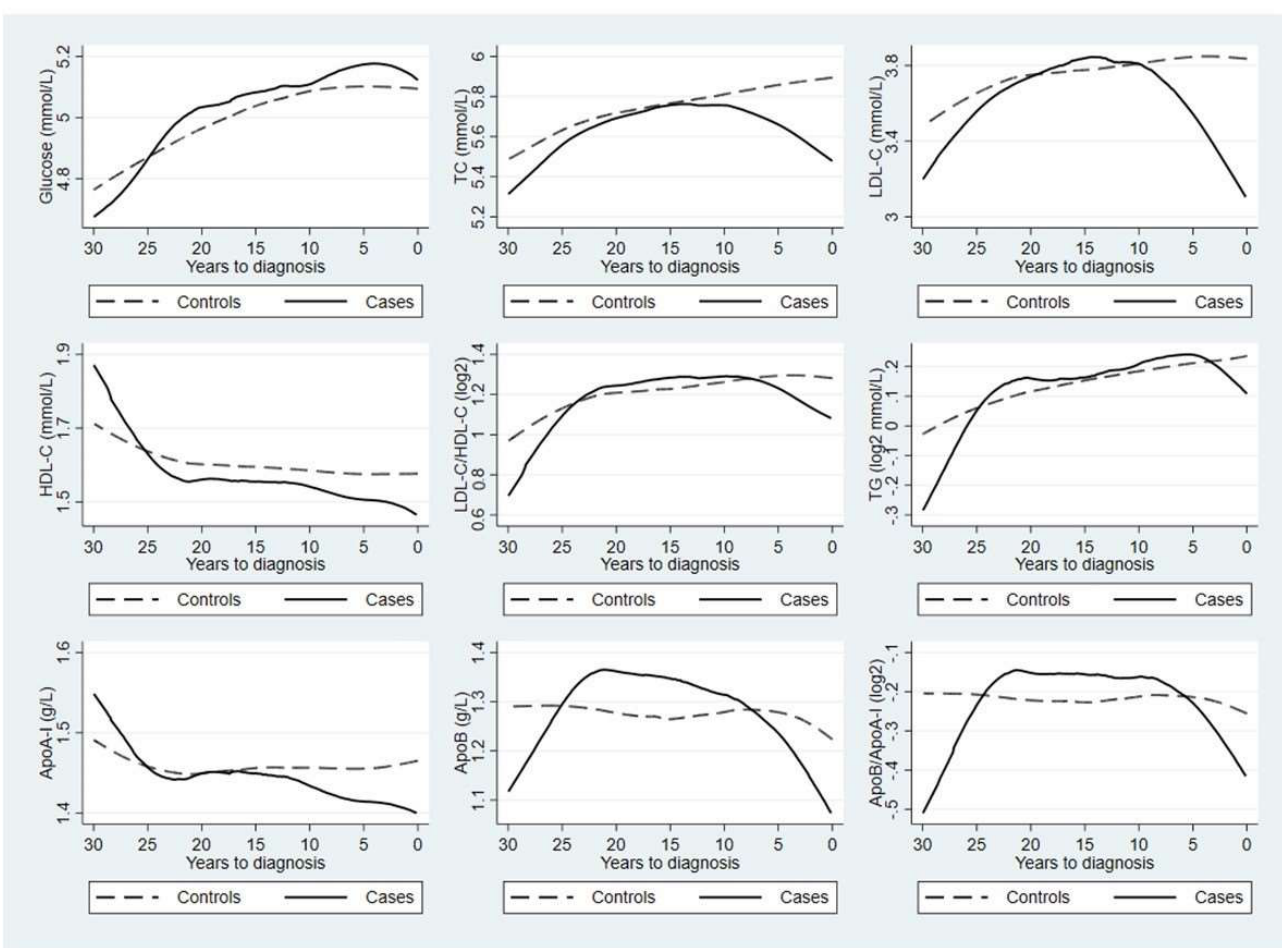
Figure 1. Mean concentrations of blood lipid, carbohydrate, and apolipoprotein biomarkers during the 30 years before index date, comparing patients with thyroid cancer (solid line) to their individually matched controls (dashed line). The curves are generated using the locally weighted scatterplot smoothing methods for the mean concentrations based on all available blood samplings during the 30-year period. Abbreviations: TC, total cholesterol; LDL−C, low-density lipoprotein cholesterol; HDL−C, high−density lipoprotein cholesterol; TG, triglycerides; Apo−I, apolipoprotein−I; ApoB, apolipoprotein B.